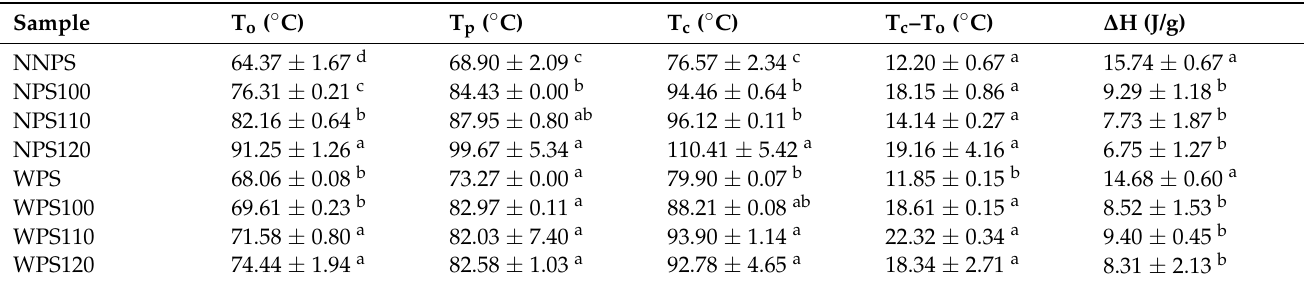
Table 2. The thermal properties of the samples.